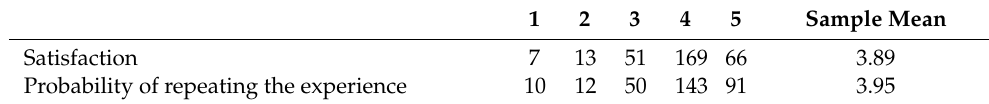
Table 4. Level of satisfaction and probability of repeating the experience in this very same establishment.